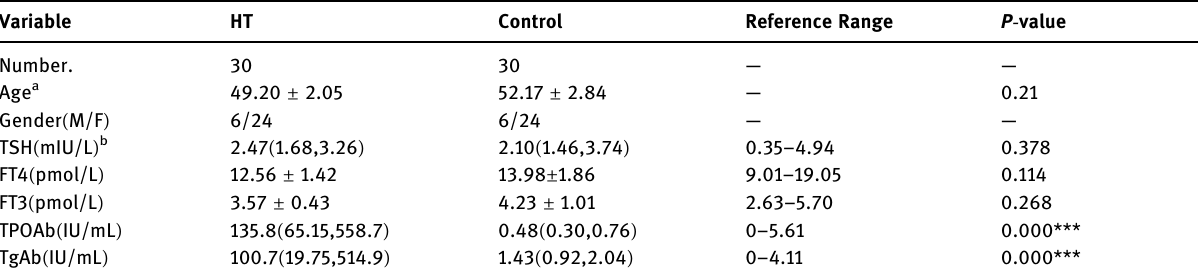
Table A1: The clinical characteristics of patients with Hashimoto ’ s thyroiditis and controls used in RT - PCR